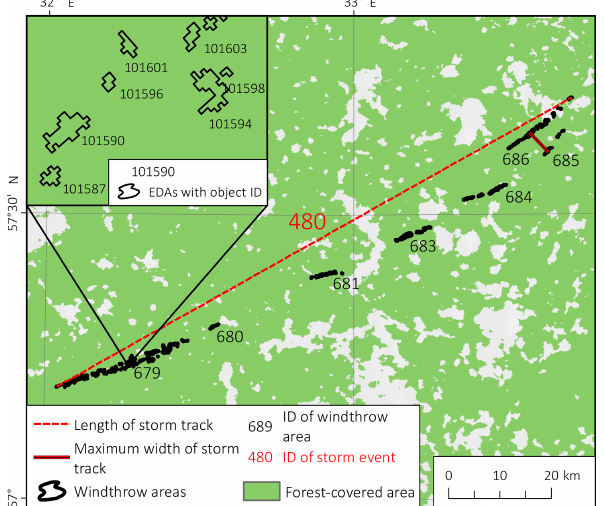
Figure 3. An example of three hierarchical levels of the database for the event occurring on 2 August 2017. A scheme for the deter- mination of geometrical parameters of a storm event is also shown. Parallel (680, 681) and successive (684, 689, 682, 678) locations of windthrow areas are indicated as